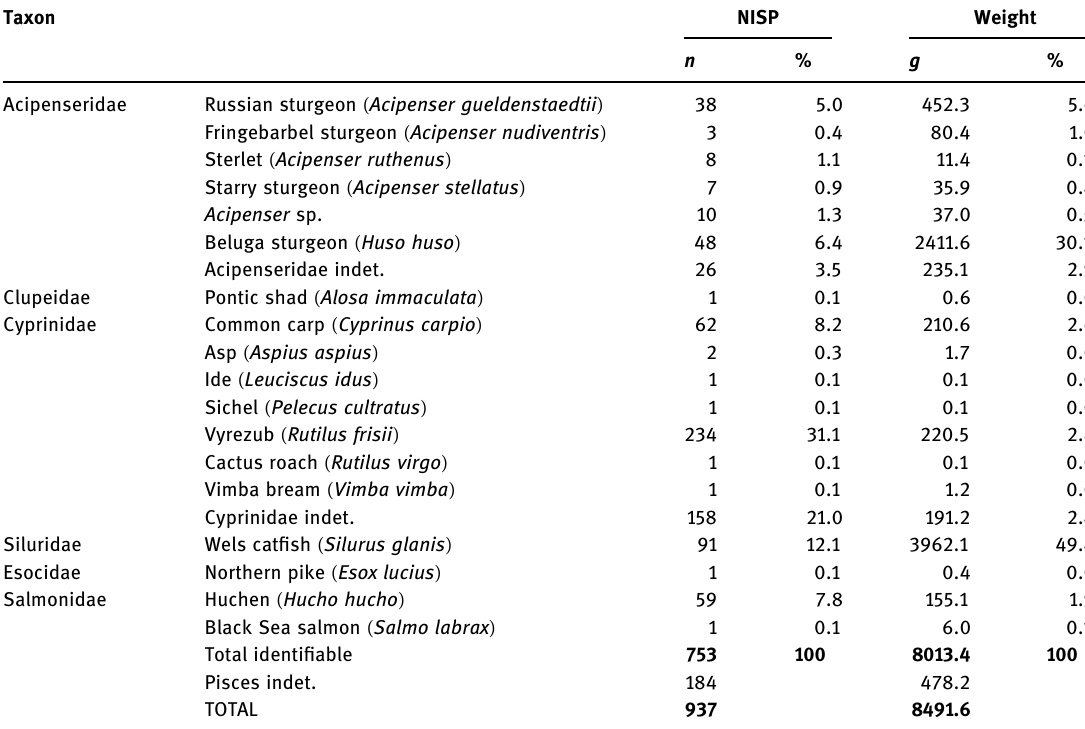
Table 1: Taxonomic composition of the fi sh faunal assemblage related to the Mesolithic – Neolithic transitional and the Early Neolithic phase of occupancy of Lepenski Vir ( cf. Ž ivaljevi ć , 2017